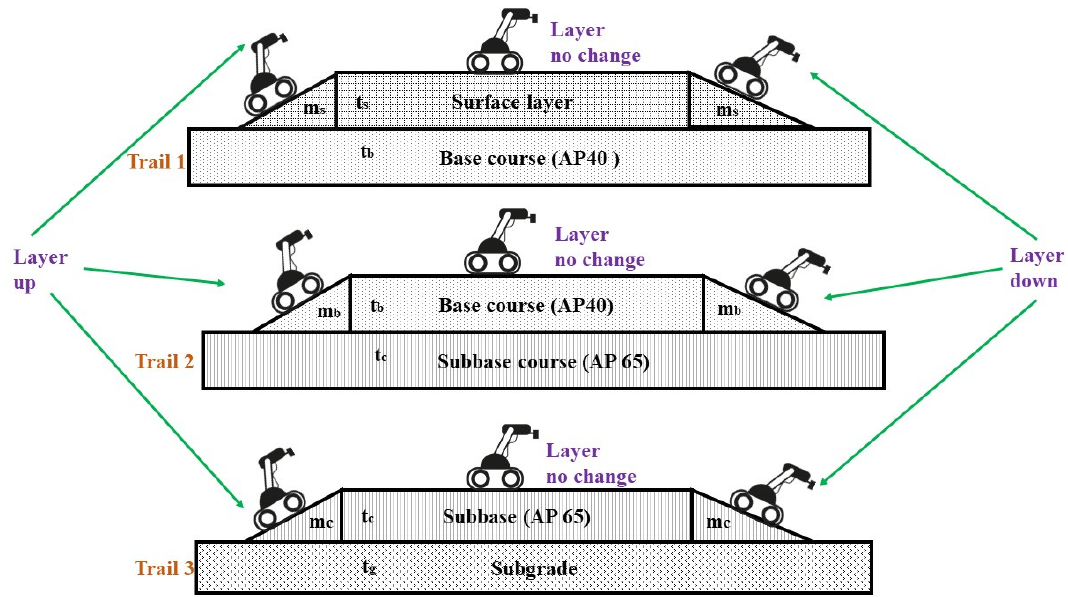
Table 1. Considered variable values for data collection .